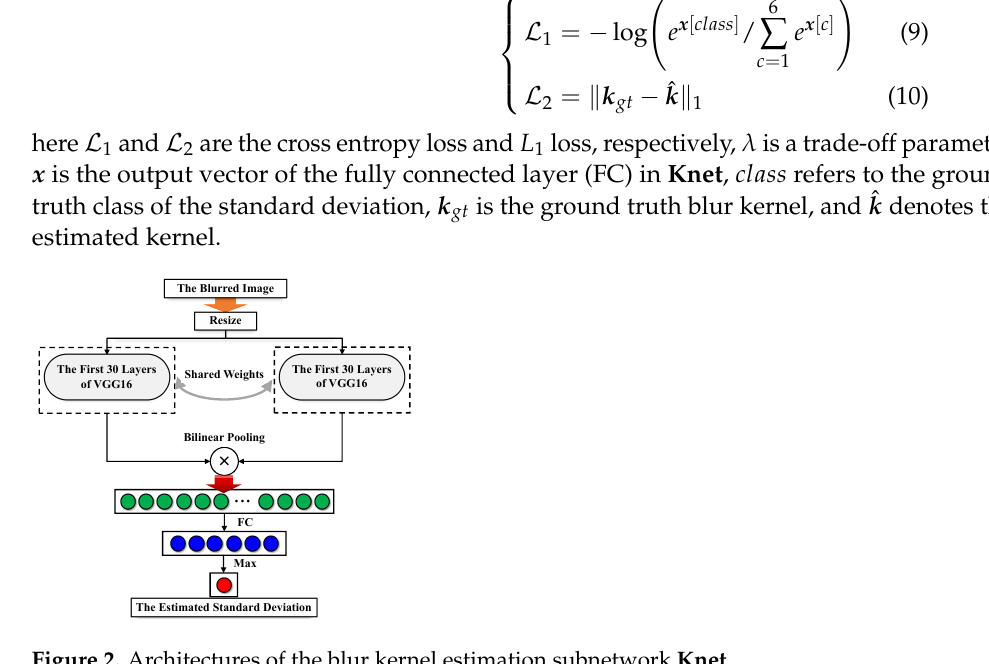
Figure 2. Architectures of the blur kernel estimation subnetwork Knet